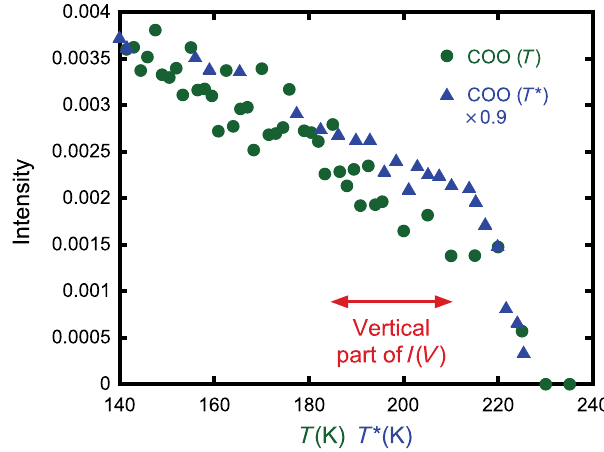
FIG. 8. The integrated intensities of the COO peaks in thermal equilibrium (green circles) are shown for crystal B as a function of T . The blue triangles represent states with high current plotted against the same T (cid:3) values used and explained in the caption of Fig. 6. The blue triangles have been scaled by a factor of 0.9, but such a shift is not unusual due to the monitor variation and general drift of the beam line after the ring is shut down and refilled. The five blue triangles with highest T (cid:3) require the same extrapolation as in Fig. 6. However, these data points are not in the critical vertical part of the I ð V Þ of Fig. 6 and thus are irrelevant to our